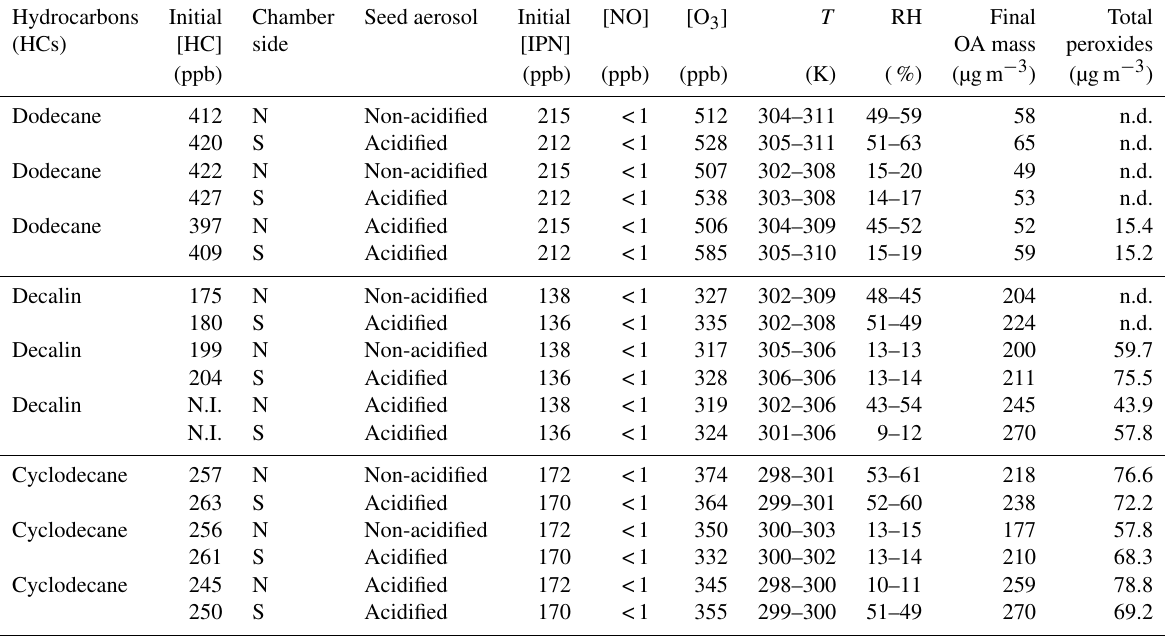
Table 1. Summary of outdoor smog chamber conditions used for the photooxidation of long-chain alkanes using isopropyl nitrite (IPN) as an OH radical